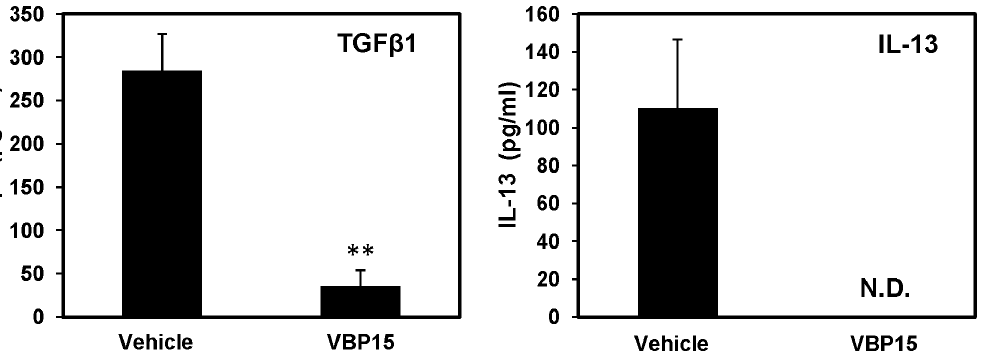
Figure 6. VBP15 reduces basolateral cytokine secretion from human bronchial epithelial cells obtained from asthmatic patients. HBE cells from 3 separate human donors were pulse-treated with VBP15 (10 m M) or vehicle control (DMSO). Basolateral surface supernatant was tested for the presence of TGF b 1 (left panel) and IL-13 (right panel) by flow cytometric bead array. Bar graphs represent mean ( 6 SE) concentration values. **, p , 0.01 compared to vehicle control with n=3 donors. N.D.=Not Detectible (lower limit of detection=4.5 pg/ml).